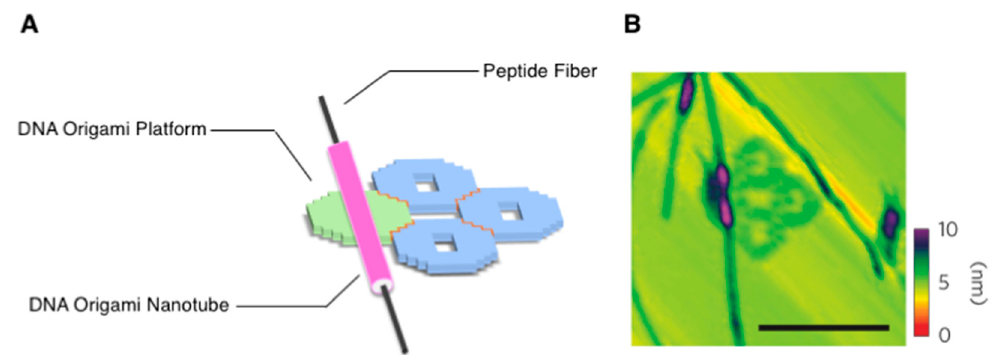
Figure 8. (A) Schematic illustration and ( B ) a representative AFM image of amyloid fibril-filled DNA origami nanotubes that were organized onto two-dimensional DNA origami platforms. Scale bars: 250 nm. The colour scale bar indicates height. Adapted from [75]. Copyright 2014 Springer Nature.